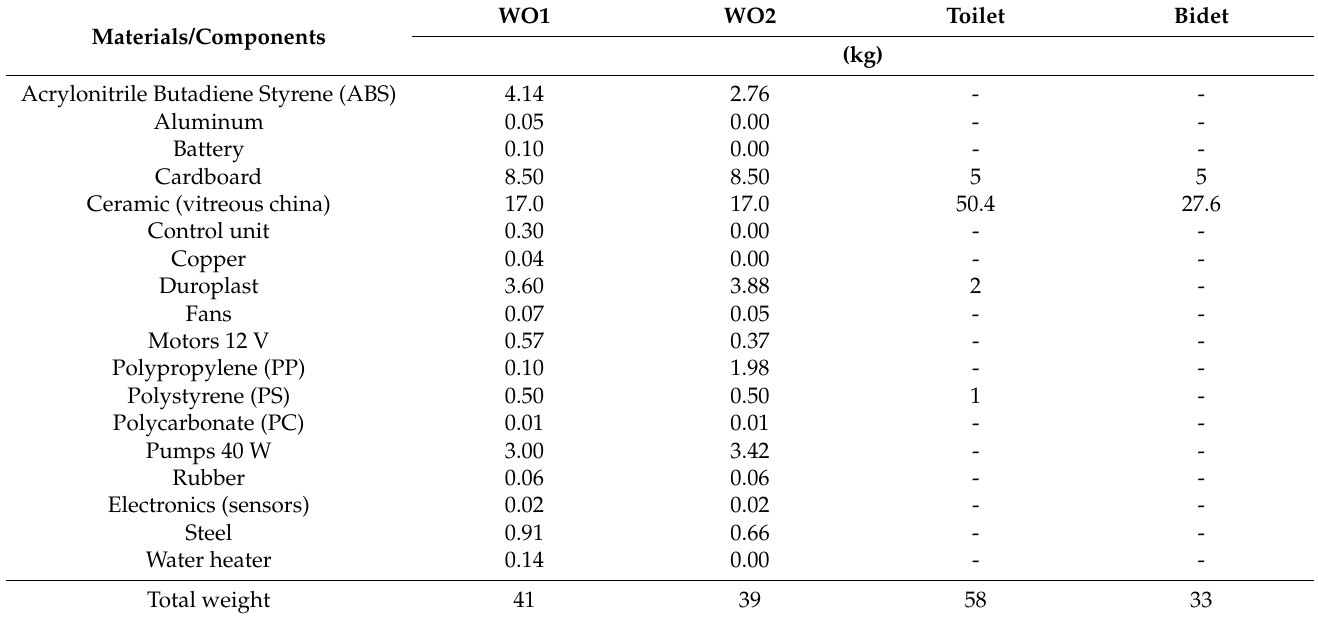
Table 1. Bill of materials of WashOne (WO1 and WO2) and conventional counterparts (toilet and bidet). Source: Developed by the authors using data collected by the authors affiliated with OLI and Sanindusa companies and from the literature. Materials/Components